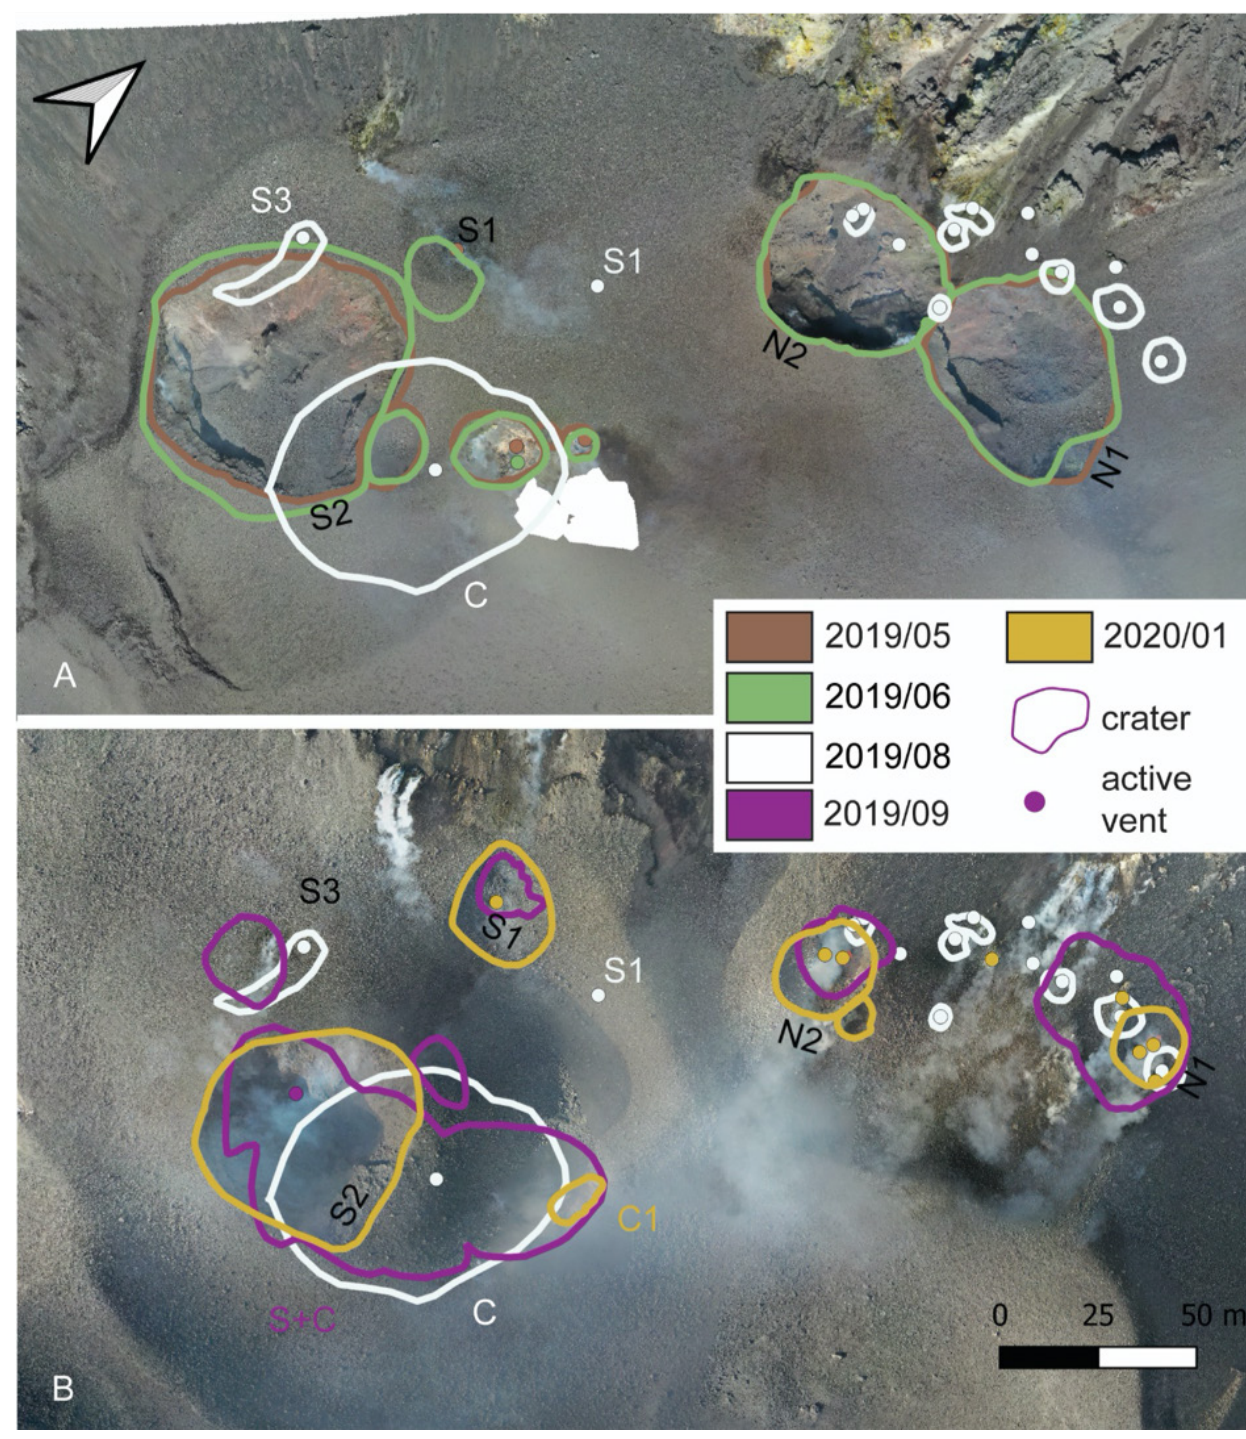
Figure 6: Orthomosaic of the area of interest between May 2019 and January 2020. [A] shows May 2019 with coloured outlines for crater shapes and open vents in May, June and August. [B] shows January 2020 with coloured outlines for crater shapes and open vents in August, September 2019 and January 2020. [A] and [B] show the same field of view. Arrow indicates